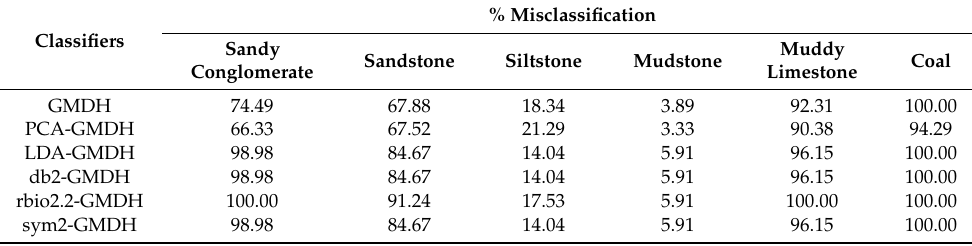
Table 7. Misclassification of the